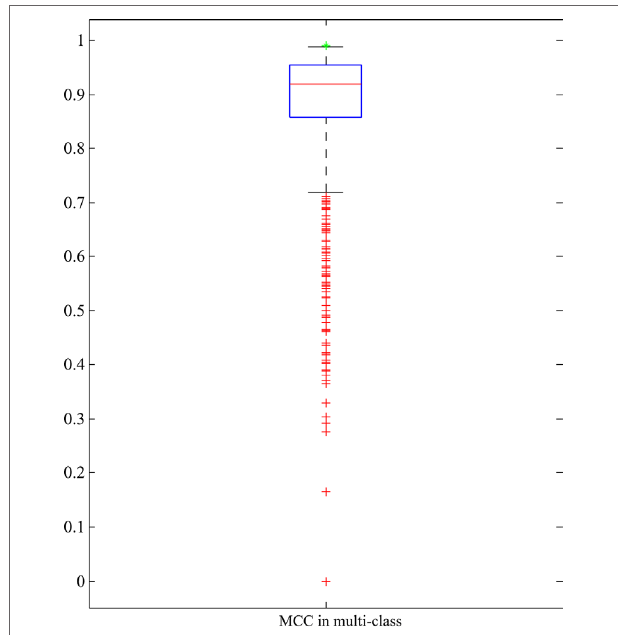
FIgURe 5 | Box plot to show the performance of RIPPER algorithm with 25 features that are randomly selected from all features. The green star strands for the MCC in multi-class yielded by RIPPER algorithm with top 25 features, which is higher than all other MCCs in multi-class on randomly selected 25